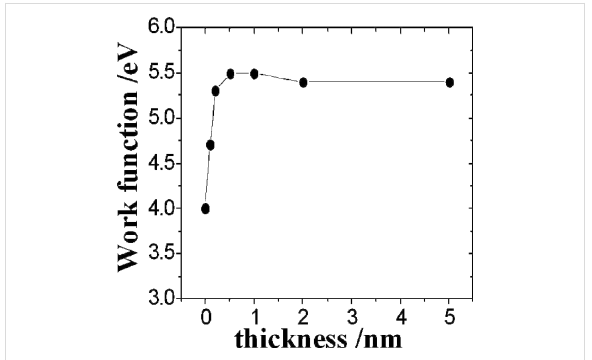
Figure 5: Plot of the workfunction of graphene (eV) as a function of the thickness (nm) of deposited F 4 -TCNQ. The workfunction of graphene